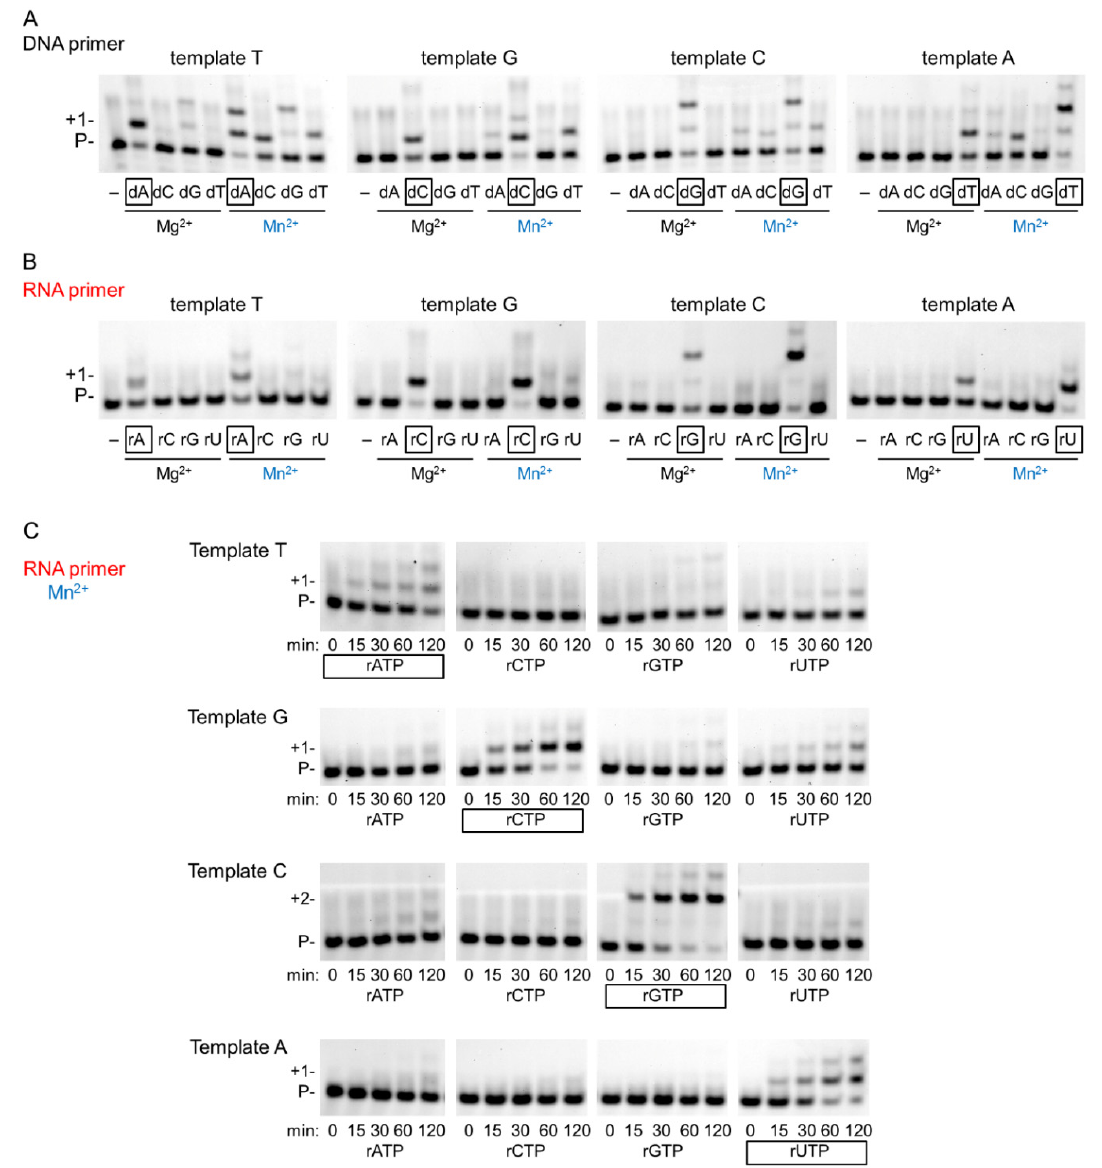
Figure 5. Fidelity of hPol η in the presence of magnesium or manganese. ( A ) To examine the fidelity of DNA synthesis, reactions were run with 3 nM hPol η , 20 nM DNA/DNA, 100 µ M individual dNTP, and 4 mM Mg 2+ or Mn 2+ , as indicated, for 1 min. The first templating nucleotide is shown above each panel and the correct incoming nucleotides are framed below the pictures. ( B ) RNA synthesis reactions were performed as in ( A ) except using 20 nM RNA/DNA and 2000 µ M rNTP for 15 min. ( C ) Time course reactions were performed with 1 nM hPol η , 20 nM RNA/DNA, 4000 µ M of individual rNTPs, and 4 mM Mn for the indicated